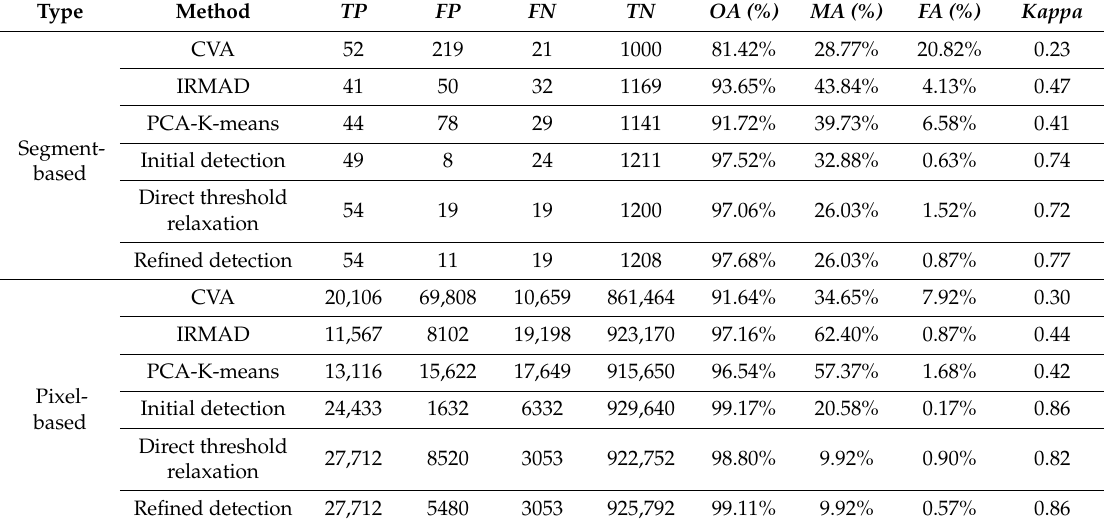
Table 2. Precision in area 1. TP: the number of change image objects correctly detected, FP: the number of unchanged image objects incorrectly detected as changed ones, FN: the number of changed image